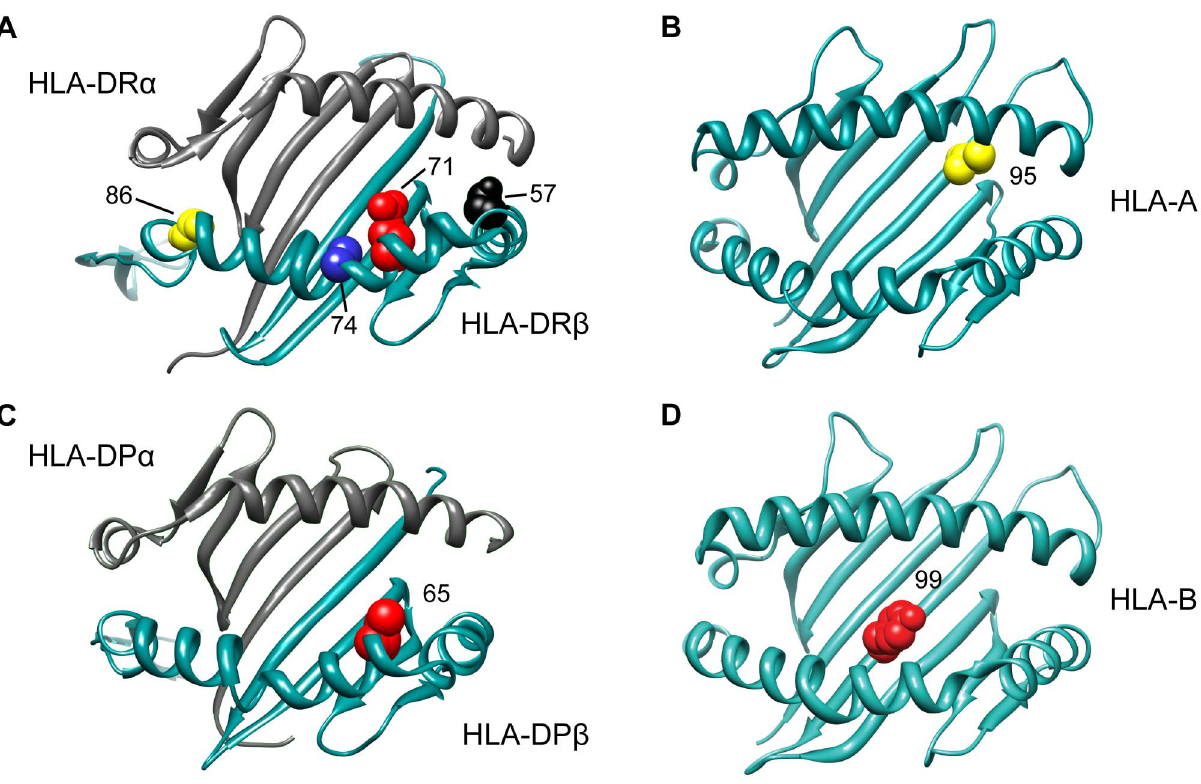
Figure 2. 3D ribbon models for HLA DR, HLA A, HLA DP and HLA B. All structures are positioned to accommodate the view of the peptide- binding groove and the associated amino acid residues. The Protein Data Bank entries 3pdo, 1a1m, 3lqz, and 2bvp were used to produce the 3D structures, respectively, using UCSF Chimera [49].